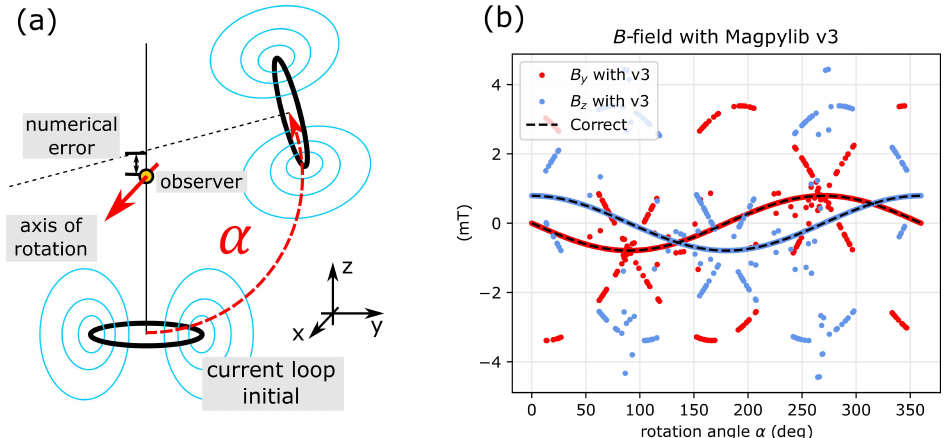
Figure 2. ( a ) Sketch of typical current loop positioning with the package Magpylib. ( b ) Demonstrating the relevance of the numerical instability, which becomes visible when a current loop rotates about an